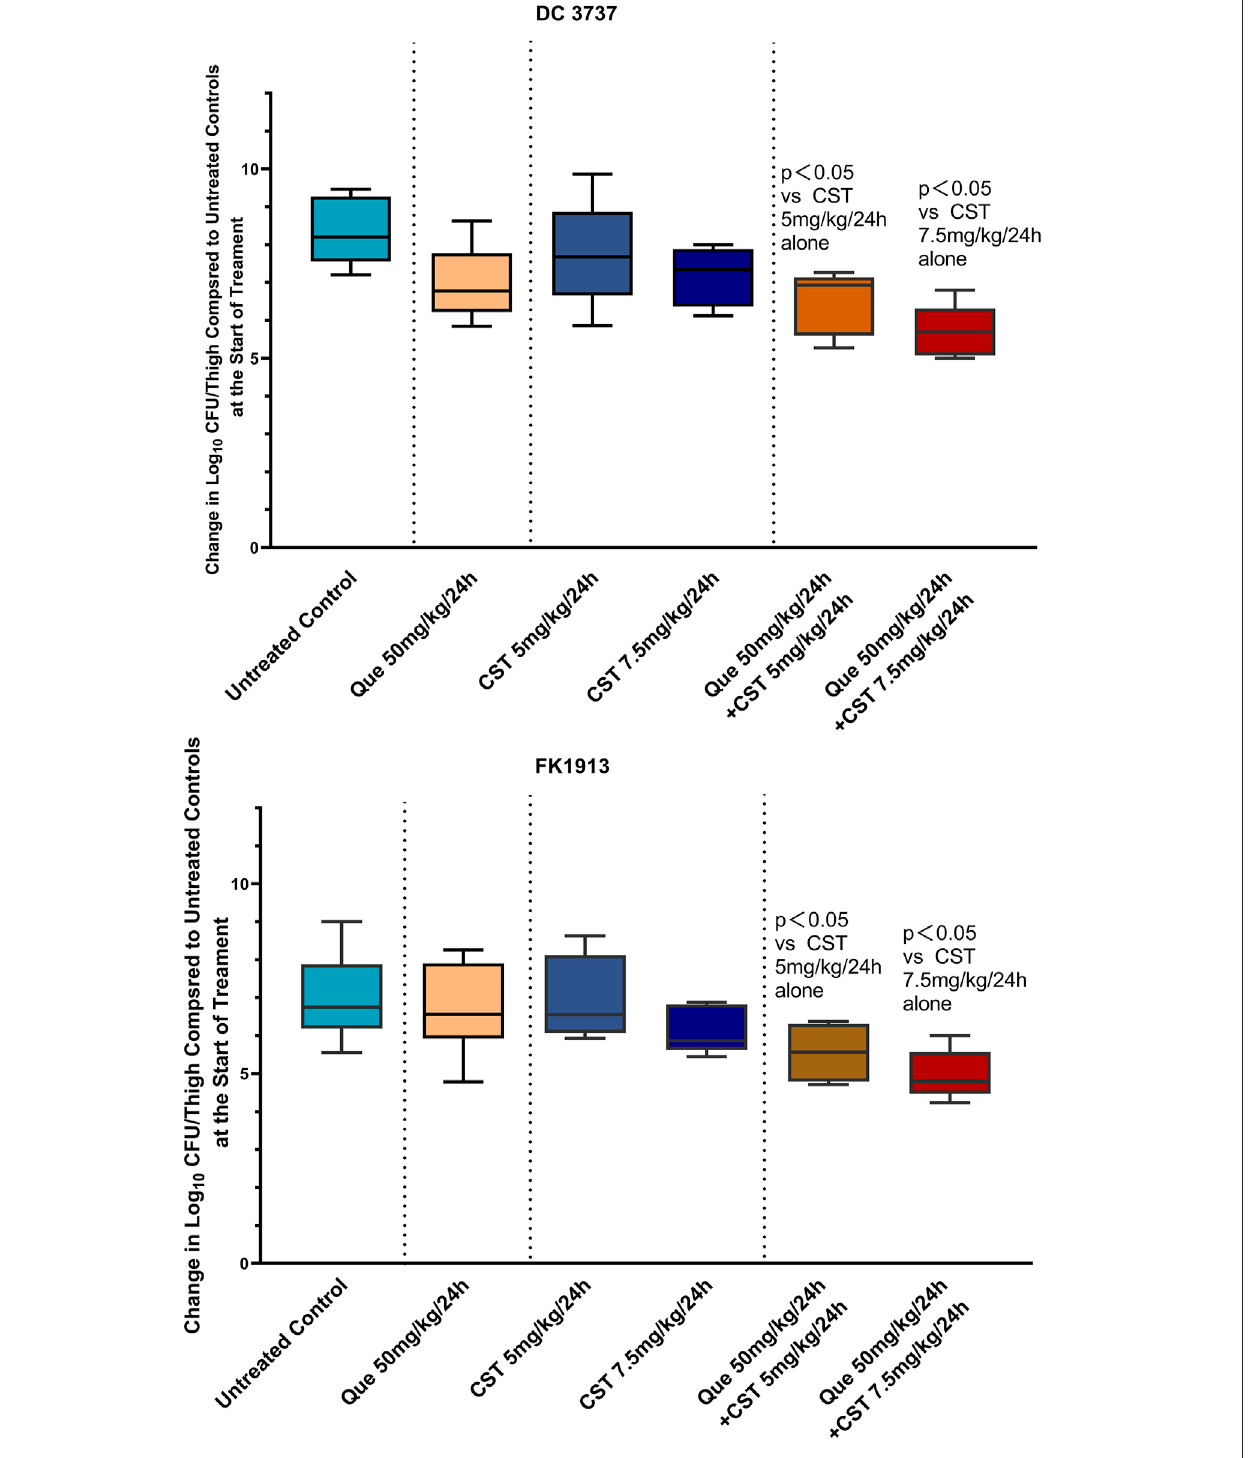
FIGURE 6 | Quanti fi ed log10 CFU/thigh in mice at 24 h post-treatment of various treatments. Changes in mouse thigh muscles ( Δ log 10 cfu/thigh) after 24 h of monotherapy or combination therapy using different dosing regimens against two colistin-resistant strains of E. coli (DC3737) and K. pneumoniae (FK 1913) (n (cid:2) 6).